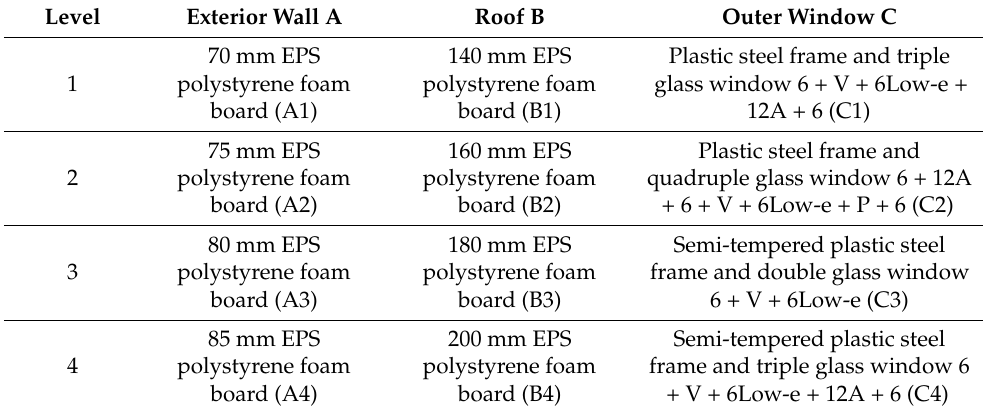
Table 5. Table of orthogonal levels and